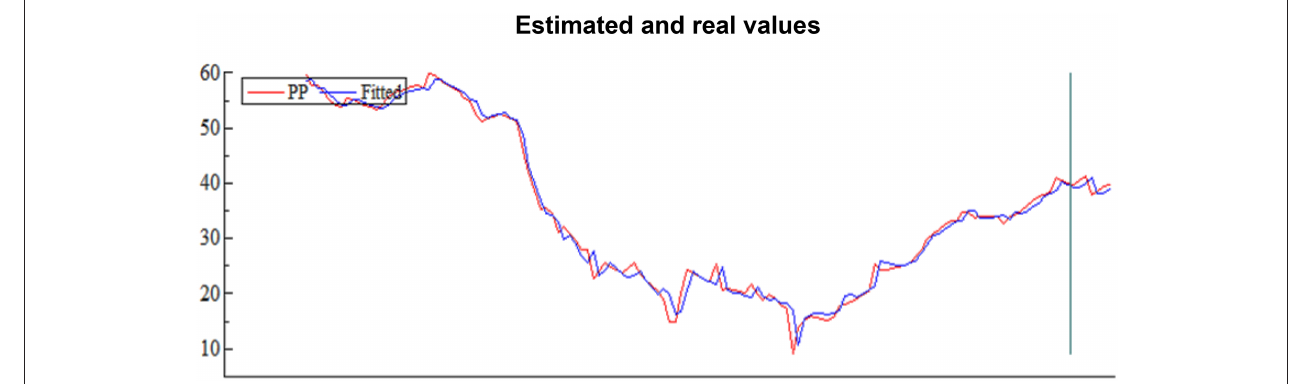
FIGURE 4 | Estimated and real